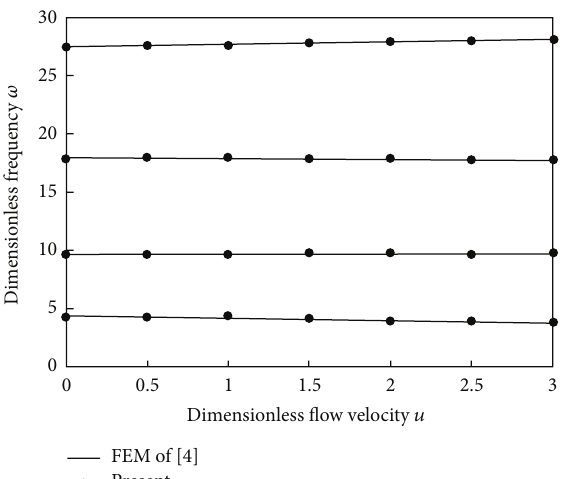
Figure 2: The lowest four dimensionless natural frequencies of a single homogeneous curved pipe conveying fluid as functions of dimensionless flow velocity for 𝛼 = 𝜋 and 𝑀 𝑟 = 0.71 .